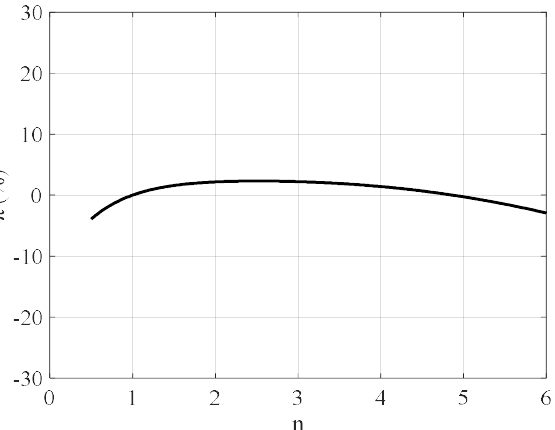
149 Figure 3. The angular velocity for the case of Equation (43) when using the Cveticanin approach (blue curve) [30] and He’s approach (red curve) [13].